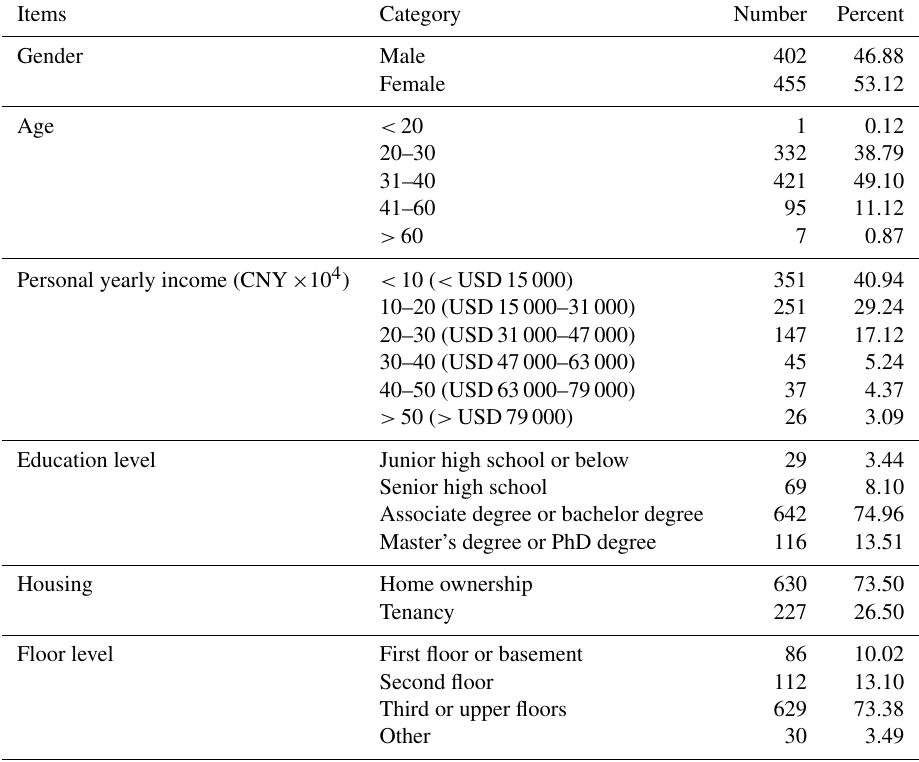
Table 2. Socio-economic characteristics of respondents ( N = 857). Items